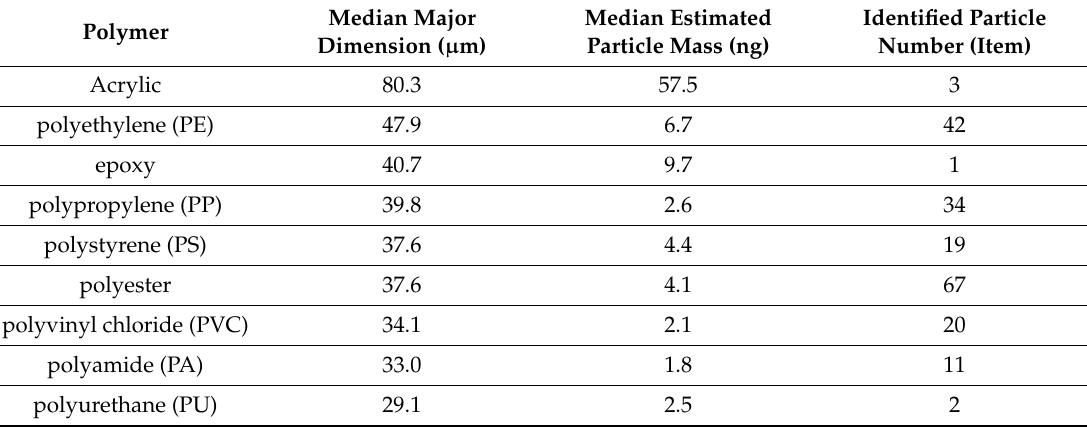
Table 1. Median value of measured major dimension, estimated mass, and identified number of particles, in each polymer group. Sum of all particles identified excl.